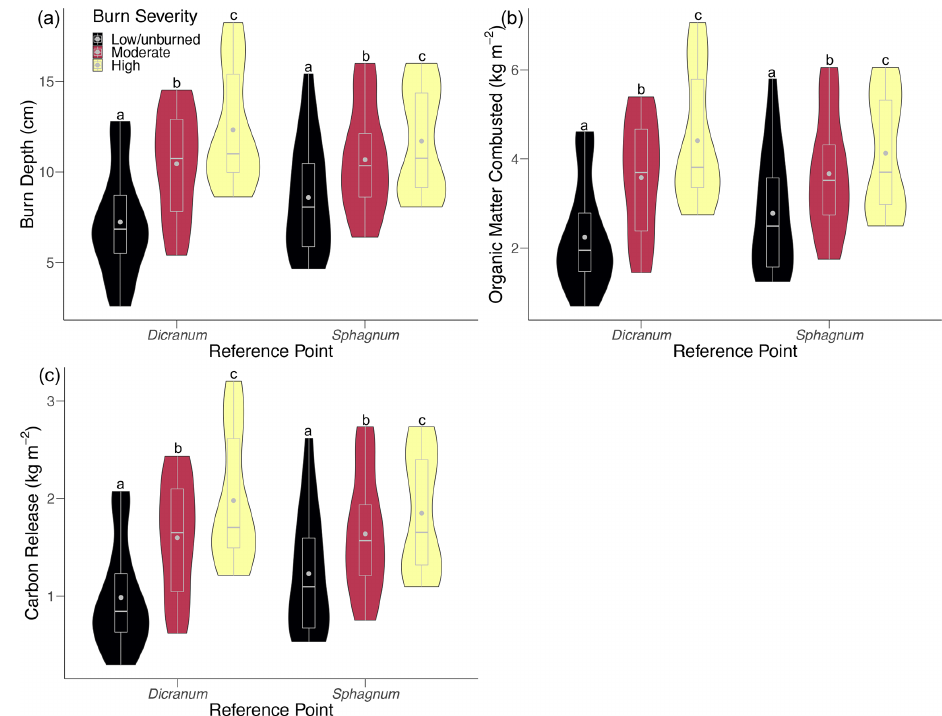
Figure 3. Distributions of average (a) burn depth, (b) organic matter combusted, and ( c) carbon released per unit burned area per transect within each reference point across burn severity levels. Boxes encompass the middle 50% of data, whiskers are the upper and lower quartiles, horizontal lines intersecting boxes show the median, and gray points are the mean. Letters indicate significantly different groups of data. Table 1. Bulk density, height, and carbon and organic matter percent, as well as pool sizes of vegetation and fibric layers measured in unburned soils averaged across reference points. Carbon and organic matter pool measurements are the product of bulk density and their percent contents and are normalized to the height of the vegetation layer and 10cm in the fibric layer. Sample size is 72, which is equally attributable to the two reference points. Error is reported as the standard error of the mean